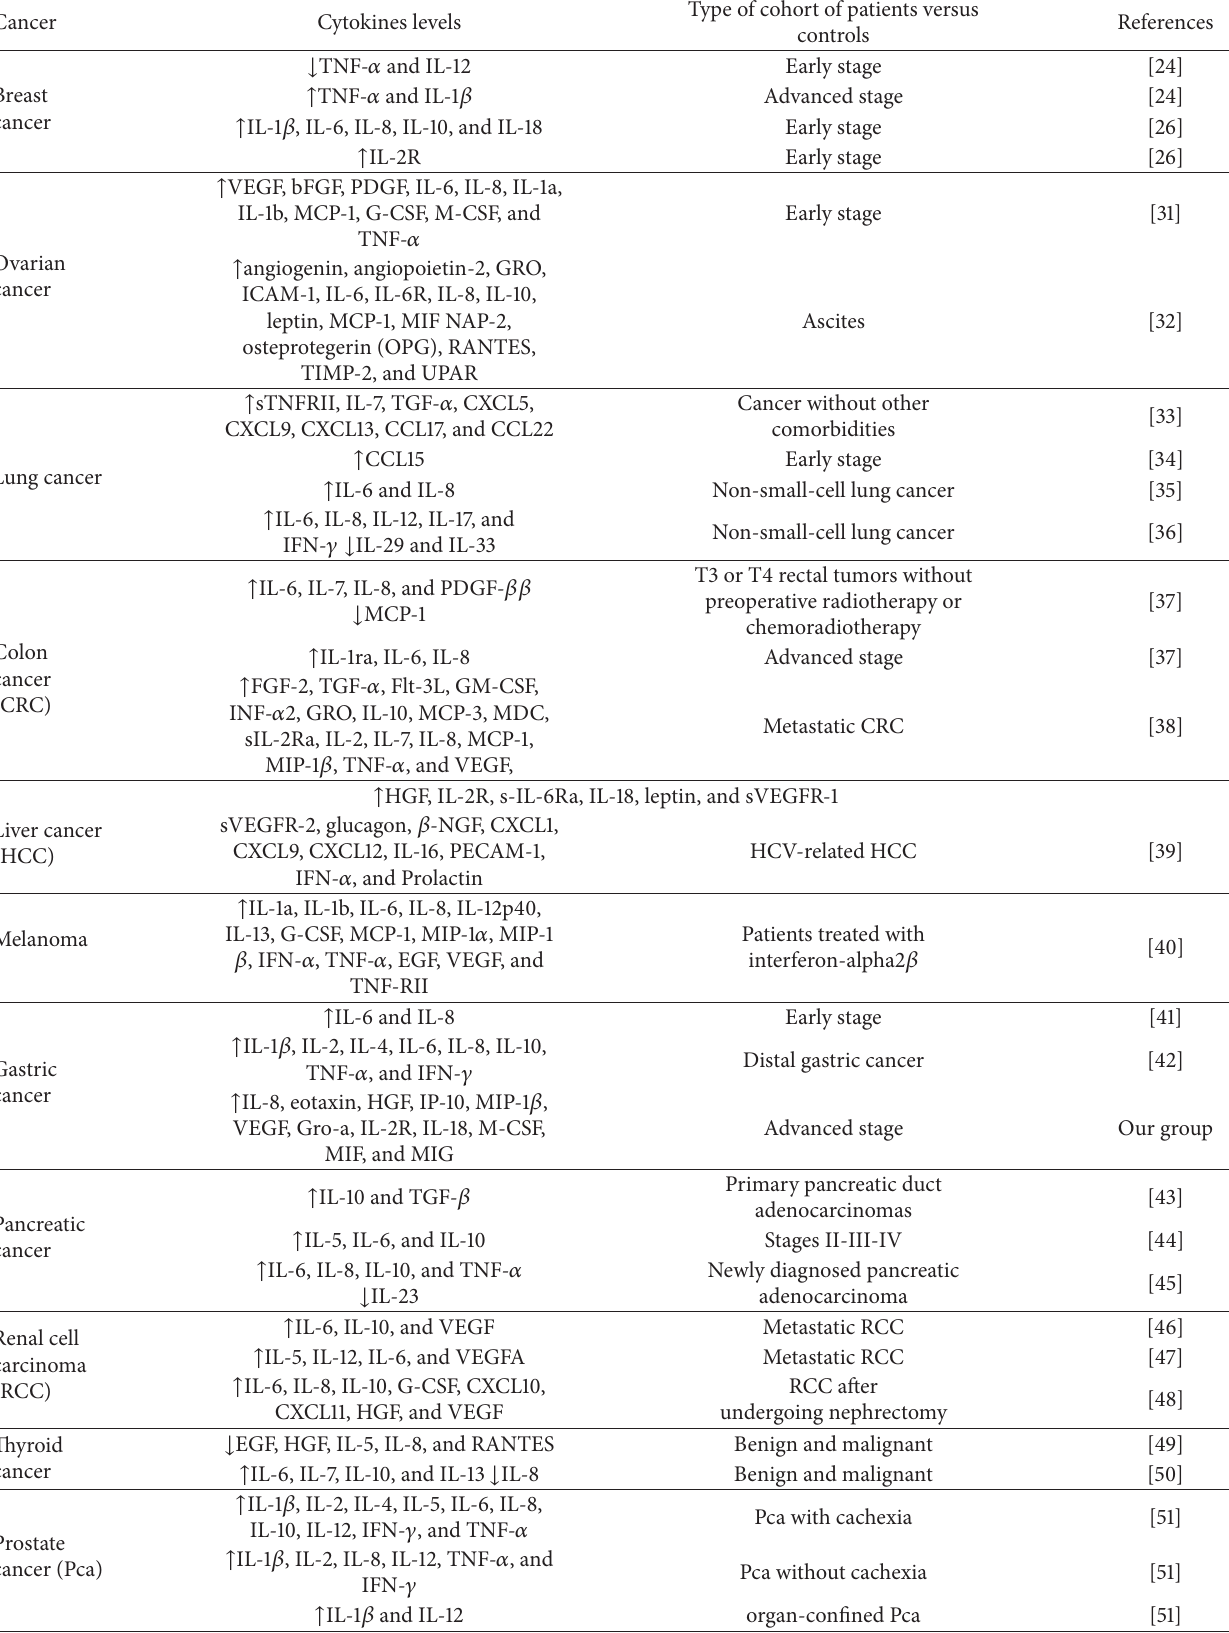
Table 1: We report for each cancer the list of cytokines of patients with higher or lower levels compared to healthy controls, the type of cohort of patients for which the sera levels of cytokines were evaluated by multiplexed bead-based immunoassays, and related